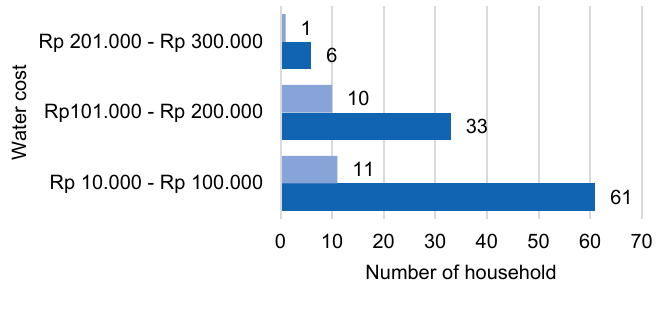
Table 2. The number of households whose water expenditure exceeds their ATP. Income Number of households, % Low 40 out of 45 households, 88.9 Middle 24 out of 32 households, 75 High 2 out of 23 households, 8.6